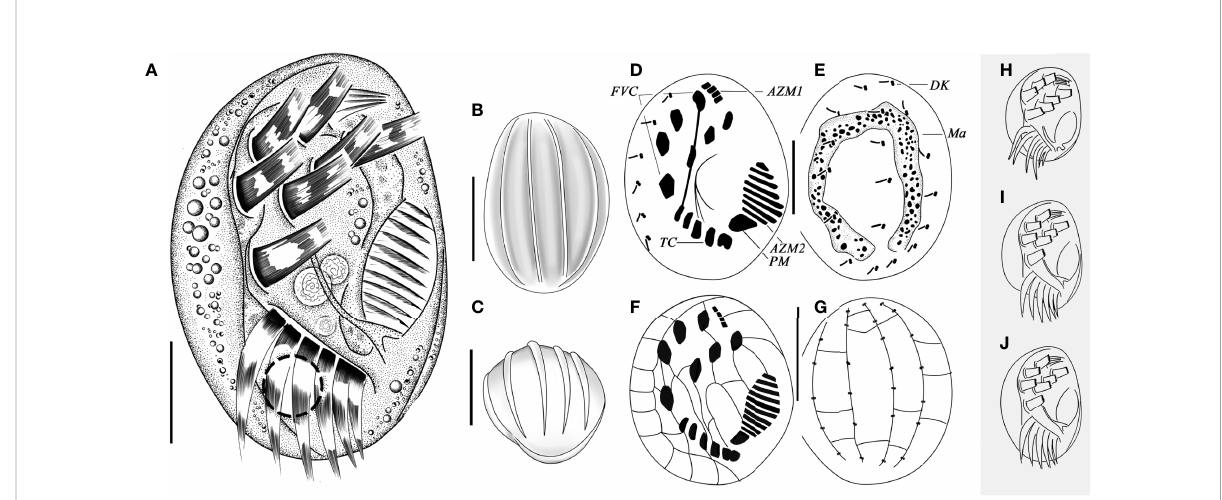
FIGURE 4 Living morphology (A – C, H – J) , infraciliature (D, E) , and silverline system (F, G) of Aspidisca shini sp. n. (A) Ventral views of a normal individual. (B, C) Dorsal (B) and apical (C) views, showing the ridges. (D, E) Infraciliature of ventral (D) and dorsal (E) sides of the specimens. (F, G) Silverline system on dorsal (F) and ventral (G) sides. (H – J) Ventral view of cells with different shapes. AZM1, anterior portion of adoral zone of membranelles; AZM2, posterior portion of adoral zone membranelles; DK, dorsal kineties; FVC, frontoventral cirri; Ma, macronucleus; PM, paroral membrane; TC, transverse cirri. Scale bars: 20 µm (B, C, F, G) , 10 µm (A, D, E) .